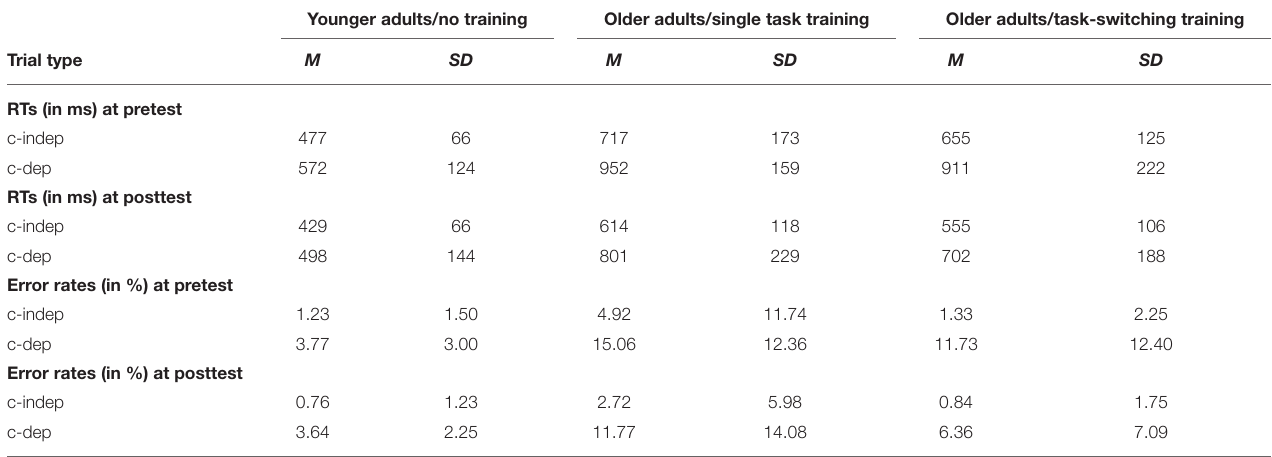
TABLE 5 | Means (M) and standard deviations (SD) for RTs (ms) and error rates (%) as a function of group and trial type separately for the pretest and posttest in the